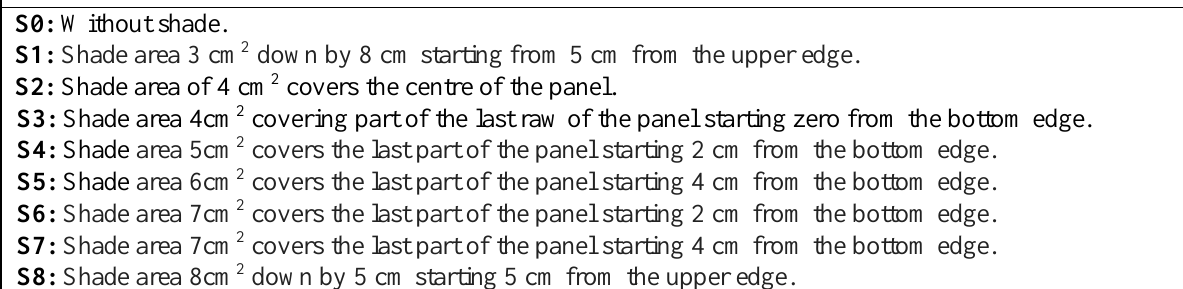
S0: Without shade. S3 : Shade area of 3cm 2 covers the centre of the panel. S4 : Shade area of 7cm 2 covers the centre of the panel. S5 : Shade area of 8cm 2 covers the centre of the panel. S6 : Shade area of 10cm 2 covers the centre of the panel. S7 : Shade area of 10cm 2 covers the top of the panel 12 PM (Illustrated in Figure 3) S0: Without shade. S1: Shade area 3 cm 2 down by 8 cm starting from 5 cm from the upper edge. S2: Shade area of 4 cm 2 covers the centre of the panel. S3: Shade area 4cm 2 covering part of the last raw of the panel starting zero from the bottom edge.